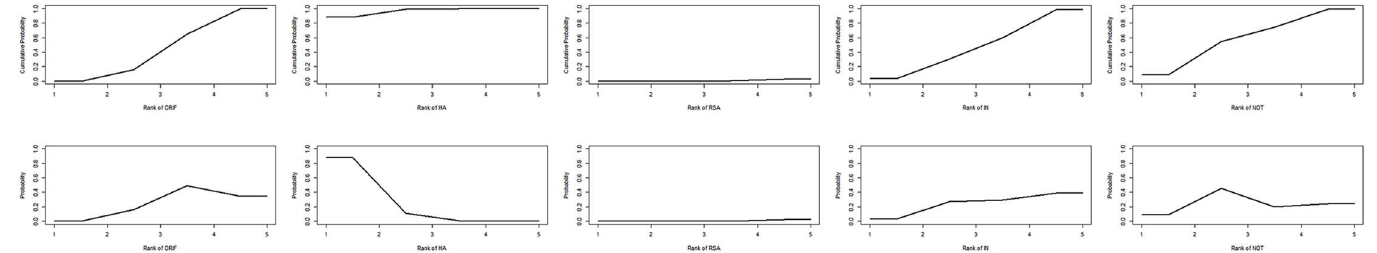
Fig 4. Ranking of treatment strategies based on the probability of their effectson the outcome of constant score. ORIF: open reductionand internal fixation; HA: hemiarthroplasty; RSA: reverse shoulderarthroplasty; IN: intramedullary nailing;NOT: Non-operative treatment.